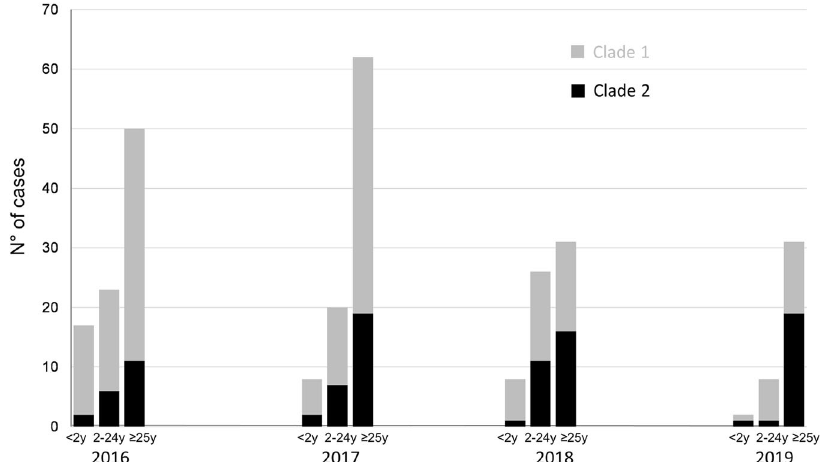
Fig. 6 Distribution of cases of IMD duo to serogroup C per age group during the period 2016 (far left) to 2019 (far right). Three age groups are shown for each year (<2 years, 2 – 24 years and ≥ 25 years). Data show the number of isolates of Clade 1 and Clade 2 per age group and per year